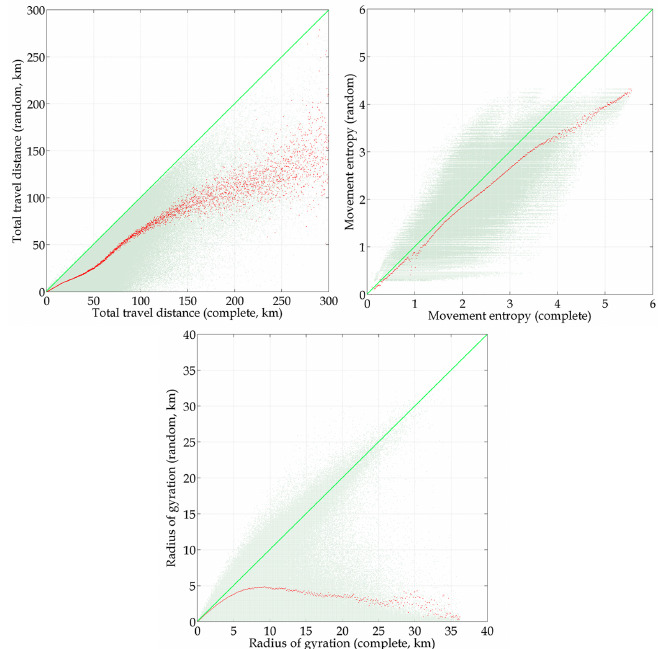
Figure 8. Human mobility indicators in 10 random segments (segment #5, #6, #7, #9, #11, #12, #14, #16, #17, and #19). The light gray dots are the three random and complete mobility indicators of each subscriber. For the total travel distance and radius of gyration, the horizontal axis is 0.1 km bandwidth. For movement entropy, the horizontal axis is 0.01 bandwidth. The red dots are the average of the gray dots in their corresponding bandwidth.